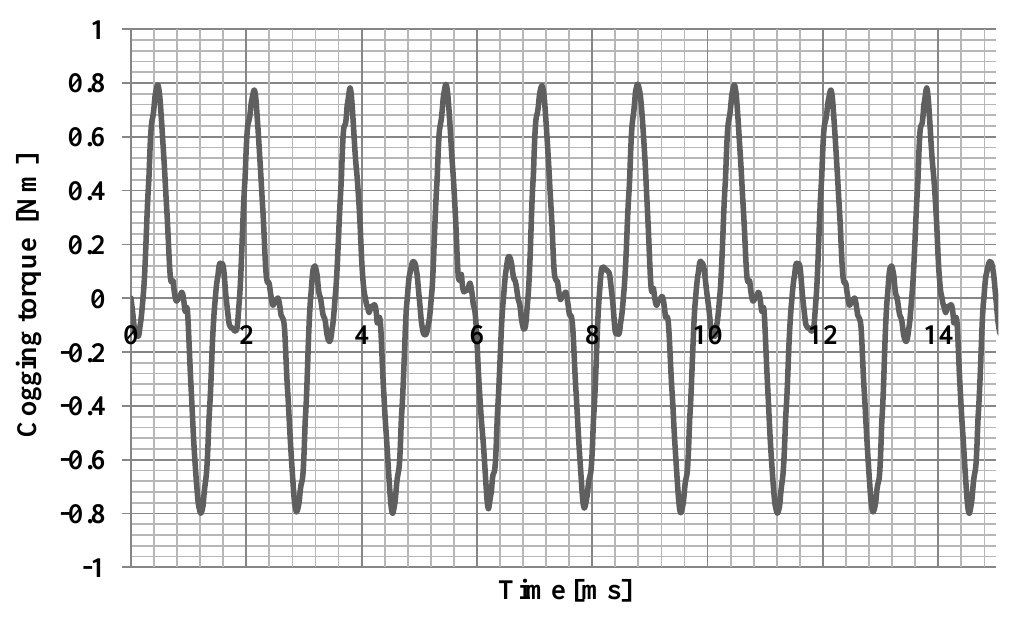
Figure 5. The characteristic of the cogging